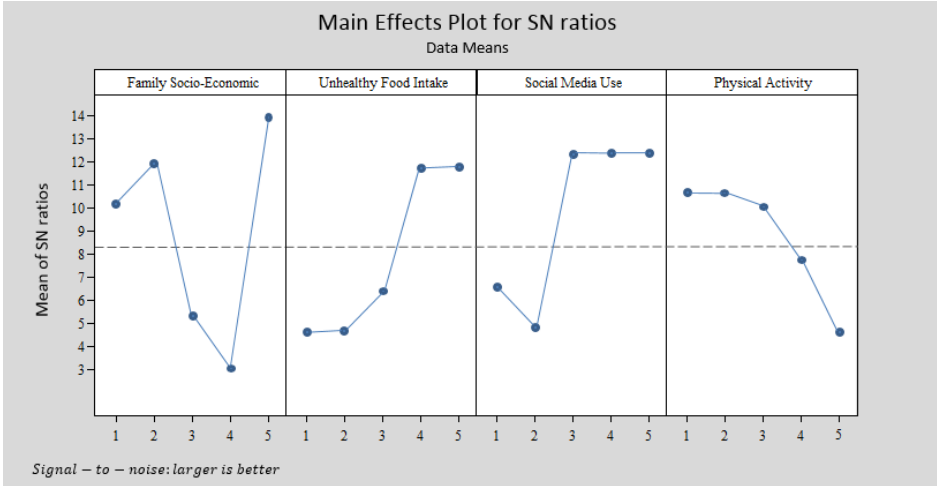
Figure 12. Taguchi output for the high school obesity model with MINITAB software.